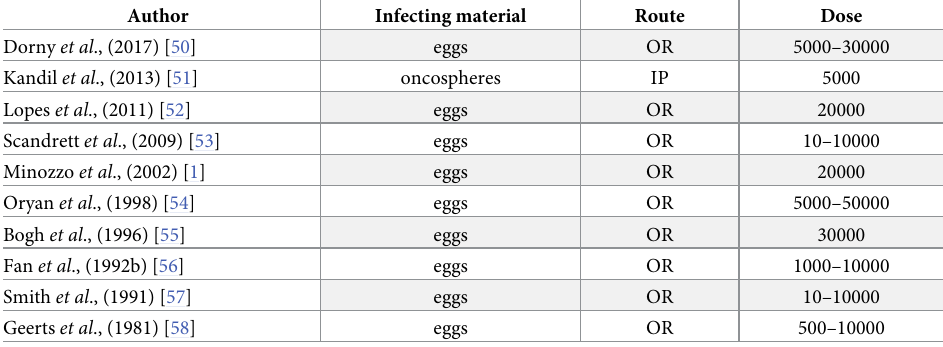
Table 6. Description of the infecting material, dose and route such as oral (O) and intraperitoneal (IP), used in the studies for T . saginata